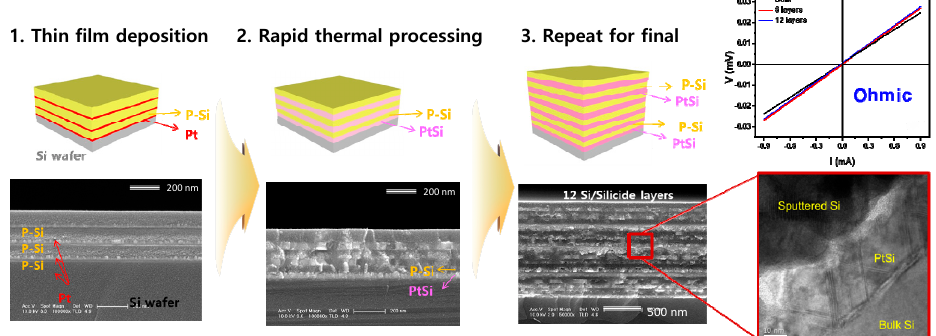
Figure 2. Fabrication process of the Silicon based thermoelectric device.